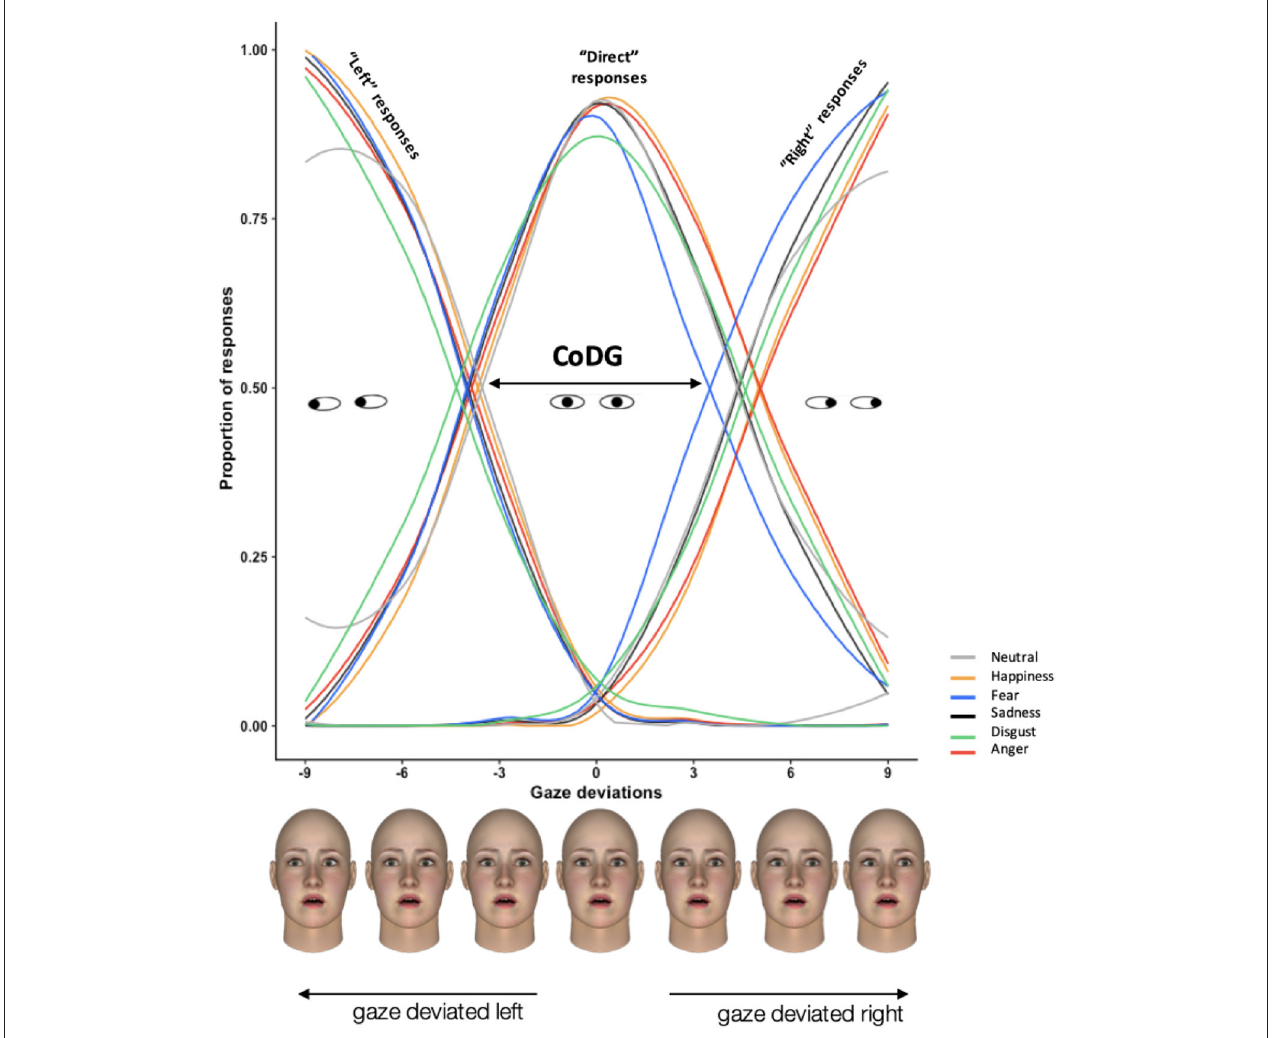
FIGURE 2 | Plot showing mean fitted left, direct and right responses as a function of gaze direction for the six emotions across all participants. The arrow represents the width of cone. Each degree of gaze deviation is illustrated with a corresponding example